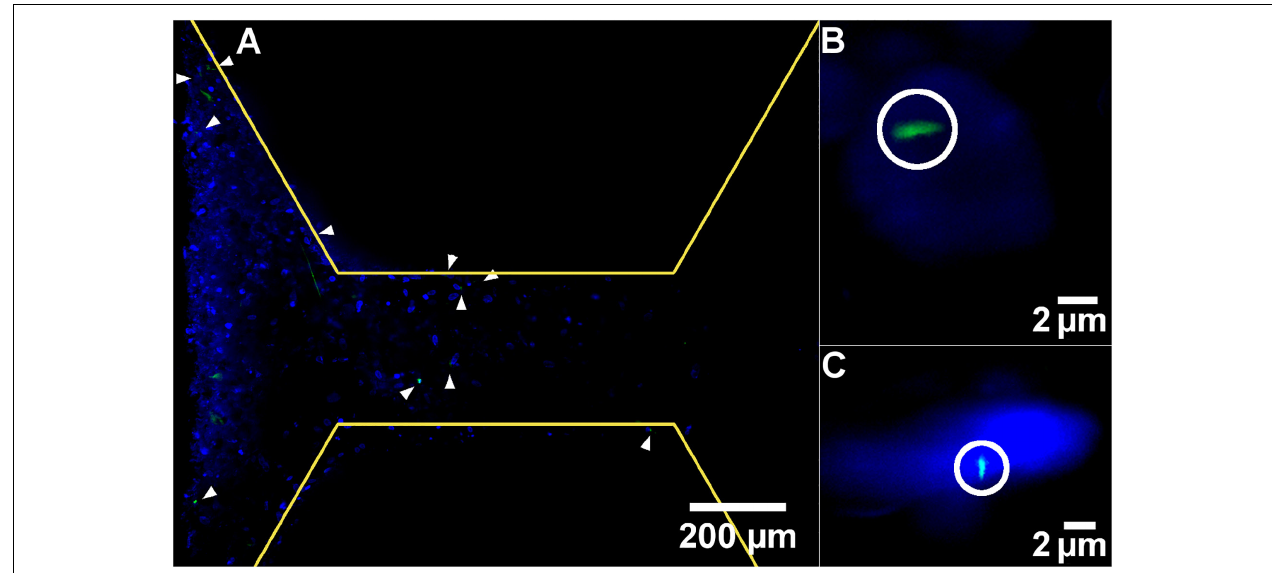
FIGURE 7 | Representative light-sheet images at (A) low and (B,C) high magnification of nuclei stained with DAPI (blue) and primary cilia stained with anti-acetylated alpha tubulin (green). White arrow heads and circles indicate primary cilia. Yellow lines demarcate the edge of the